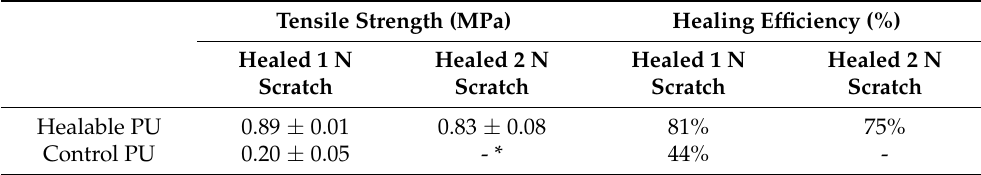
Table 3. Tensile strength of healable and control PU after healing. *: Tensile strength could not be measured since the scratch was not healed.